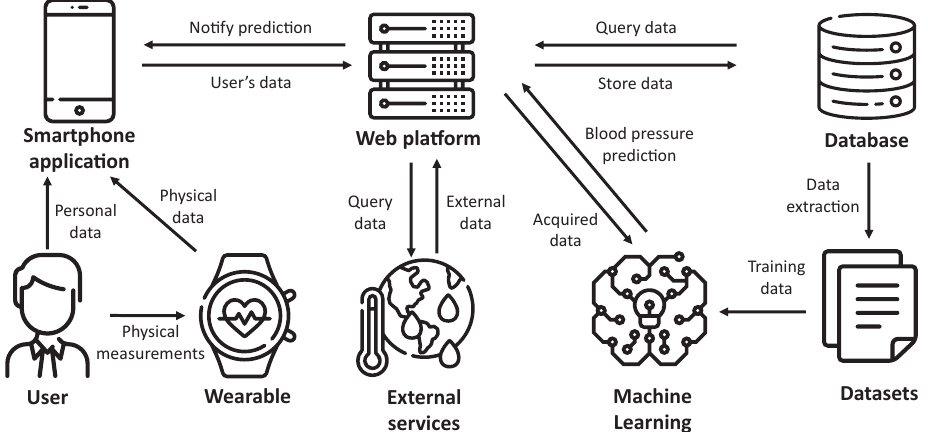
Figure 2. Complete architecture of SENIOR, including all communication flow between